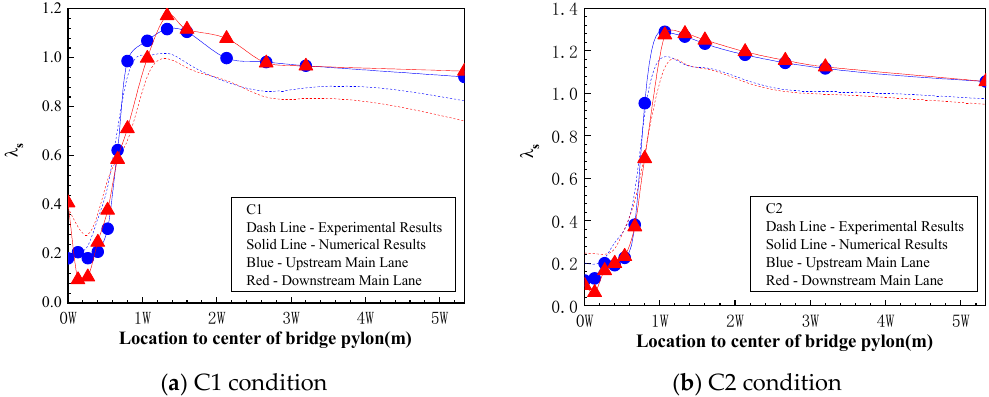
Figure 17. Comparison of influence coefficient for the experimental and numerical results.